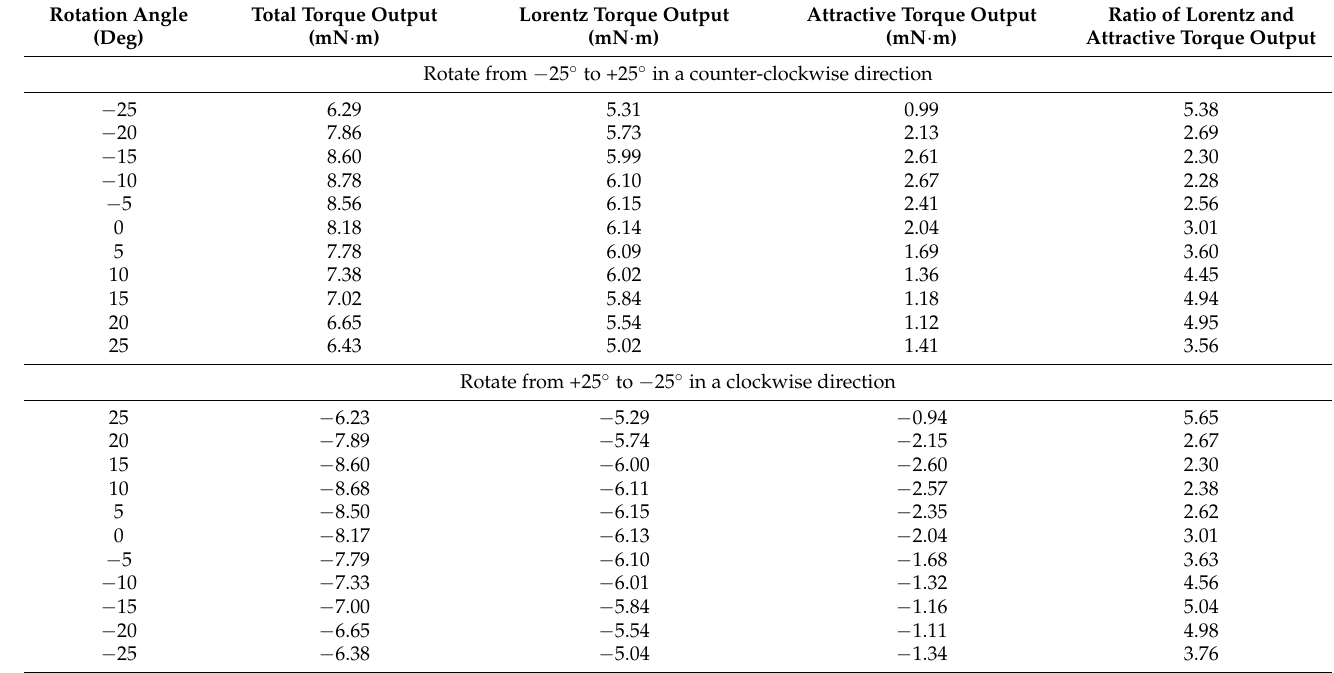
Table 3. Torque output of original 3-DOF spherical motor.